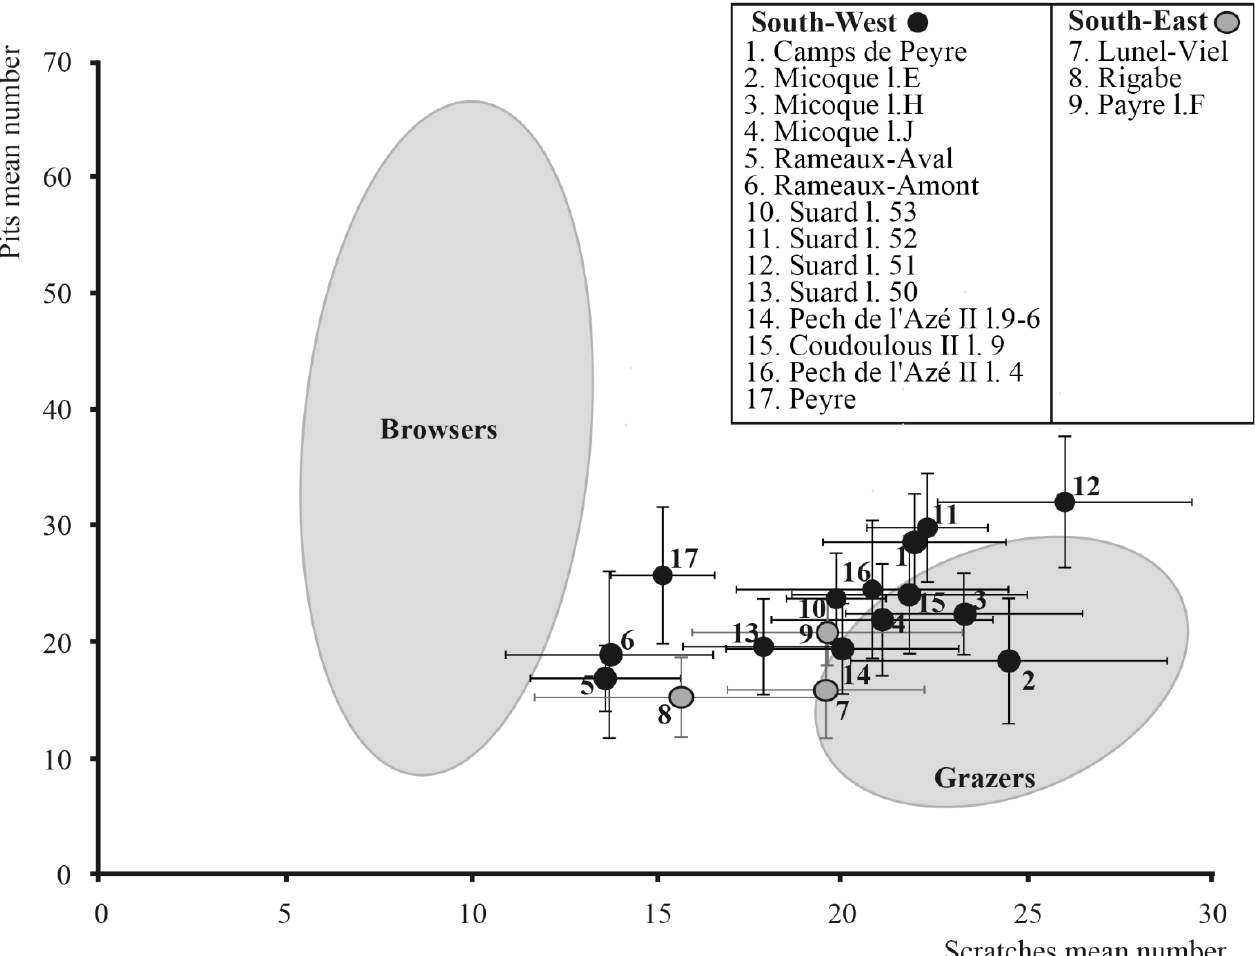
Figure 8. Bivariate plot of the average numbers of pits and scratches in horse cohorts from the South of France. Error bars correspond to standard deviations for the fossil samples. Plain ellipses correspond to Gaussian confidence ellipses ( p = 0.95) on the centroid for extant leaf browsers and grazers from Solounias and Semprebon [97]. Camp-de-Peyre: E. m. campdepeyri ; La Micoque l.E, H, J: E. mosbachensis ; Rameaux-Aval and Amont: E. mosbachensis ; Lunel-Viel: E. m. palustris ; Payre l.F: E. mosbachensis ; Suard l. 53-50: E. caballus piveteaui ; Pech de l’Azé II l.9-6: E. mosbachensis ; Rigabe: E. m. palustris ; Coudoulous II l.9: E. mosbachensis; Pech de l’Azé II l.4: E. caballus ; Peyre: E. caballus.